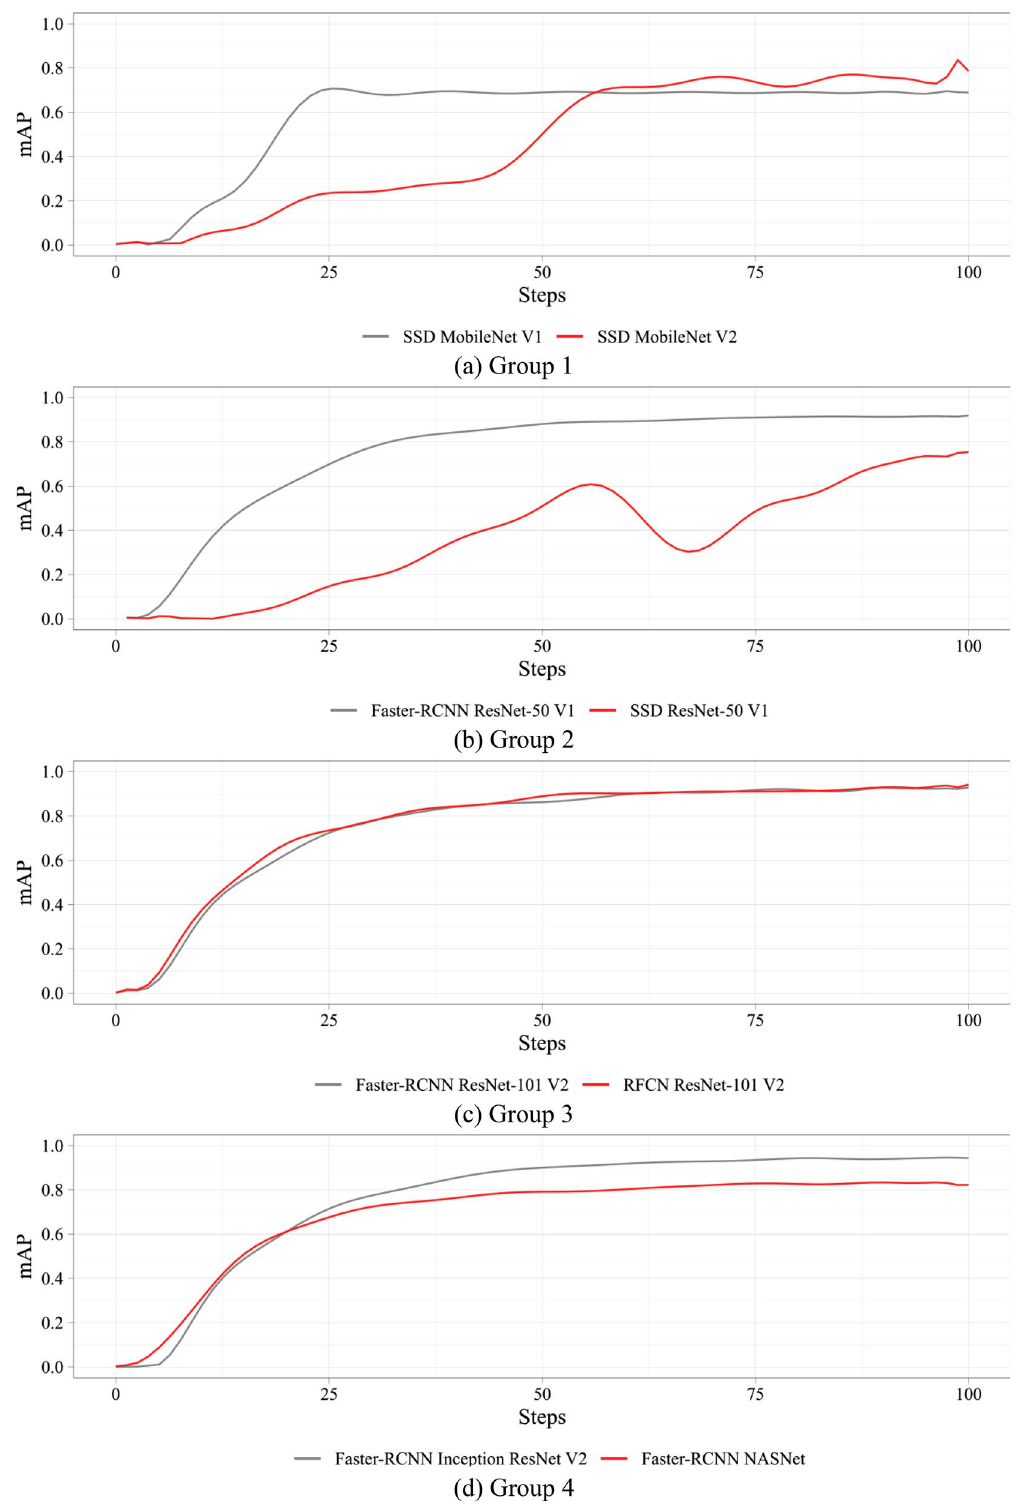
Figure 5. Dynamics of the mAP metric over the training